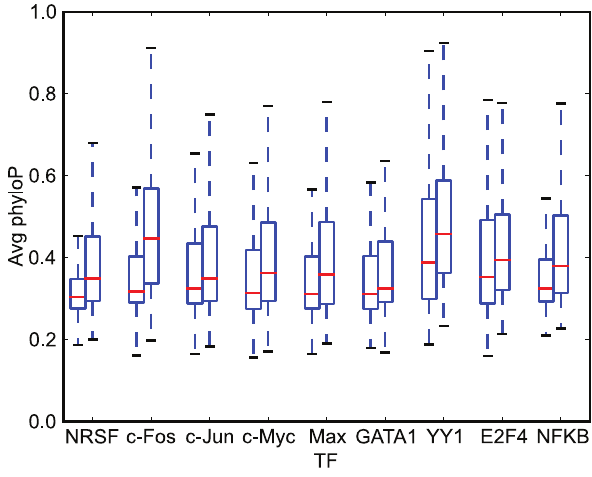
Figure 6. Distribution of phyloP scores in lowest and highest peaks. Boxplot showing for each TF the averaged phyloP scores in promoter peak regions on lowest peaks ( v 10 percentile), and highest peaks ( w 90 percentile). The higher peaks generally show higher sequence conservation across genomes.